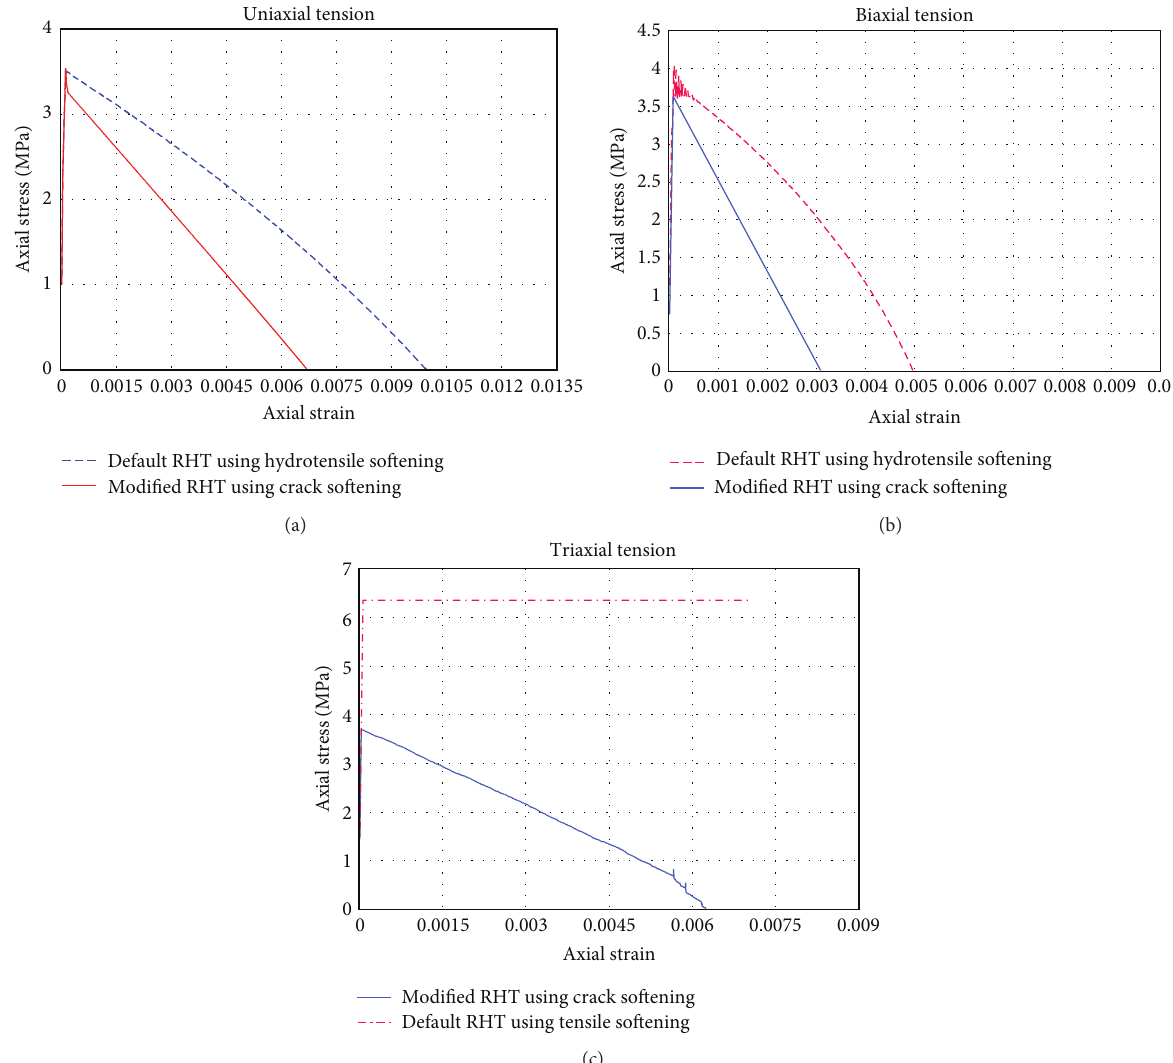
Figure 4: Comparison of tensile stress-strain curves generated by RHT